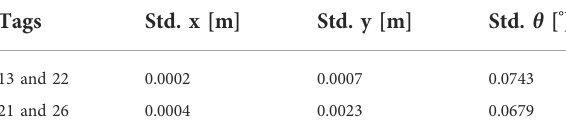
TABLE 2 Standard deviations from ground truth ’ s pose